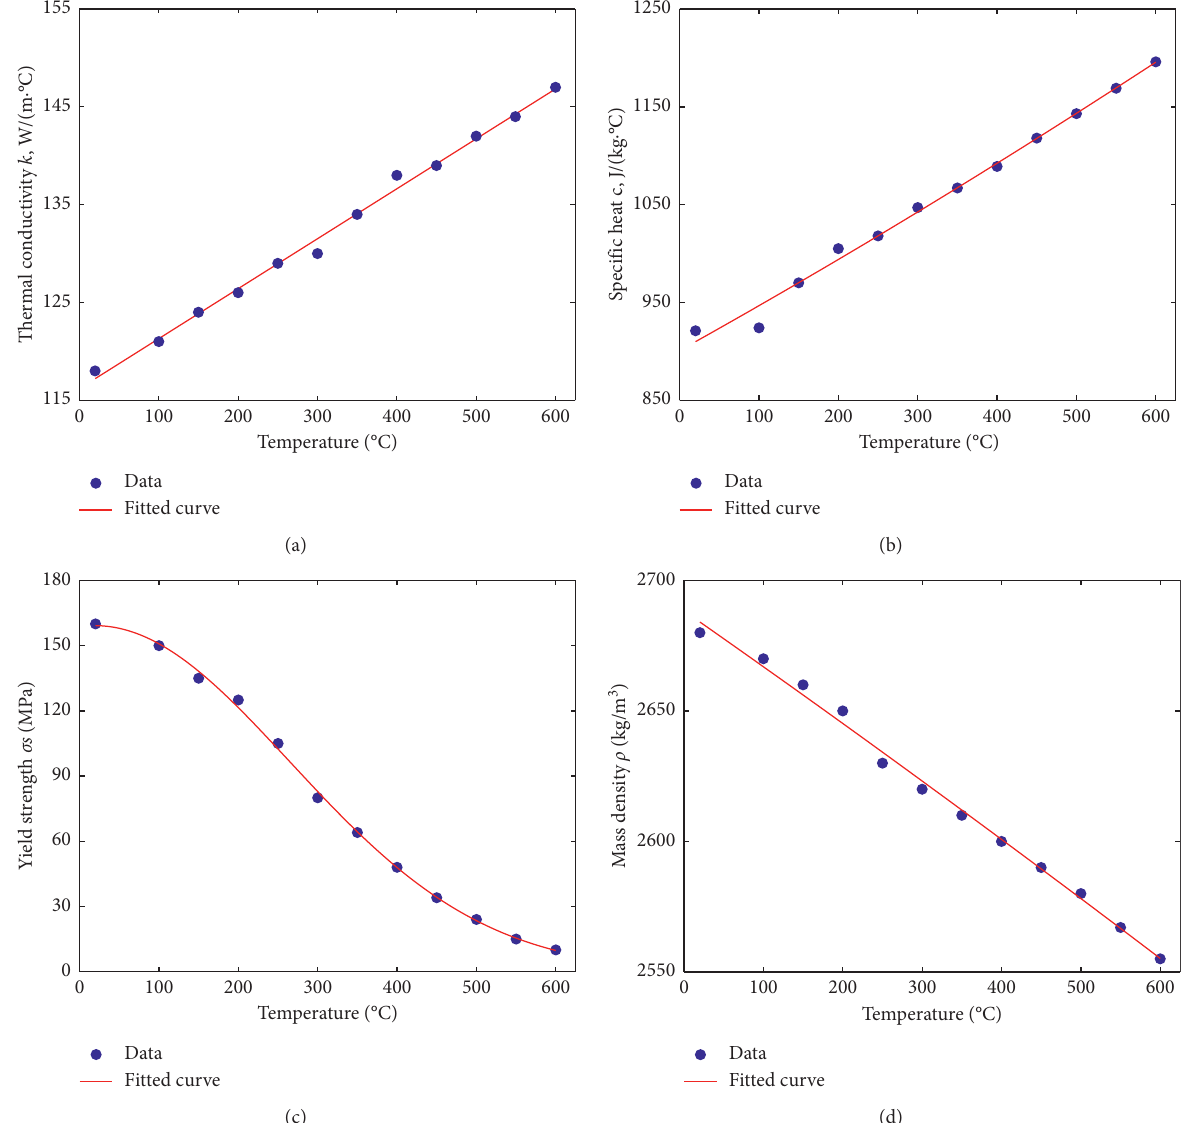
Figure 5: Thermophysical parameters used in the analytical model. (a) Thermal conductivity; (b) specific heat; (c) yield strength; (d) mass